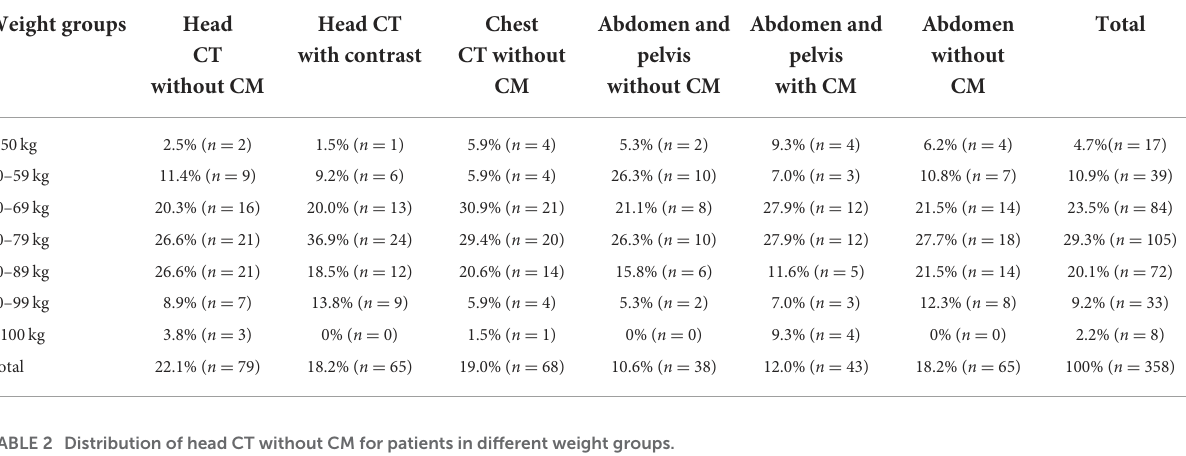
TABLE 2 Distribution of head CT without CM for patients in different weight groups.